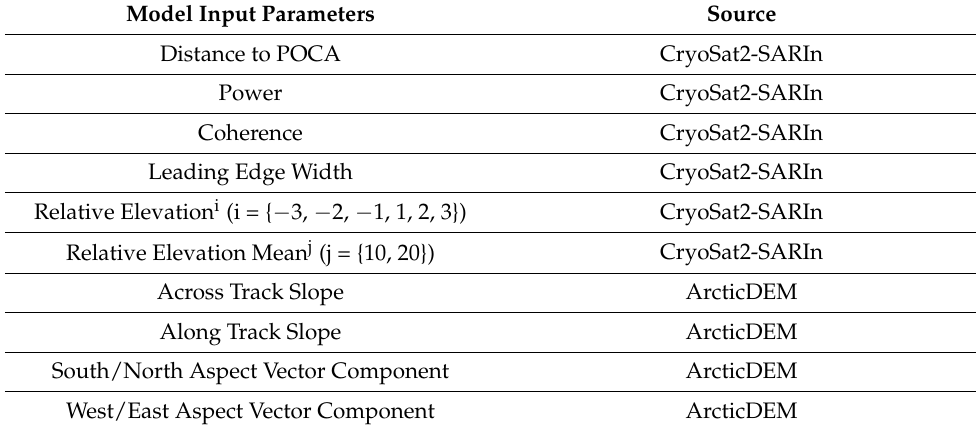
Table 1. Summary of model input parameters.